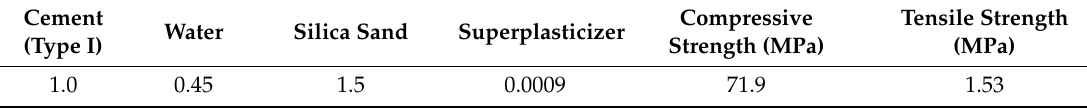
Table 1. Matrix composition by weight ratio and compressive strength [22].